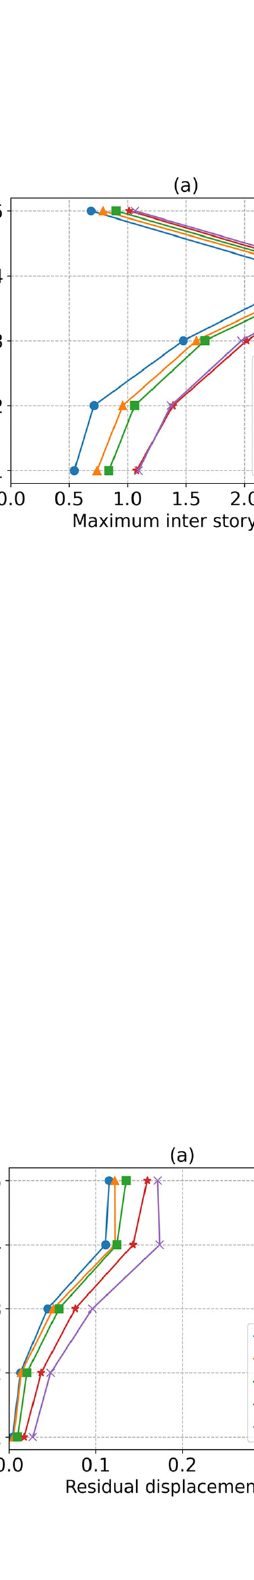
Figure 18. Residual displacement: ( a ) 5-story frames; ( b ) 10-story frames; and ( c ) 15-story frames.